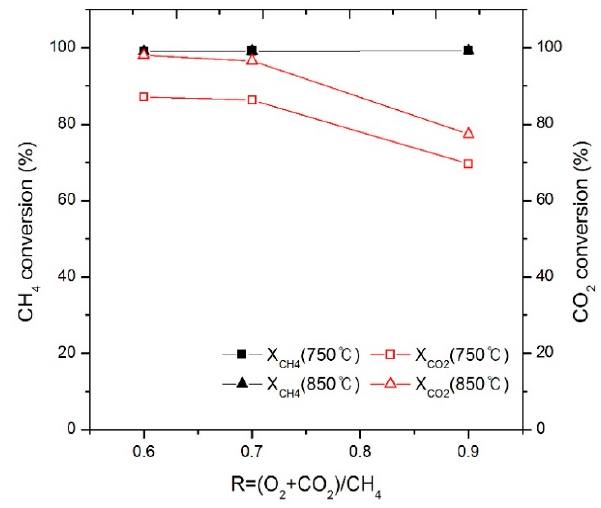
ff ect of R values on CO Figure 9. Effect of R values on CO2 and CH4 conversion rates. Figure 9. E